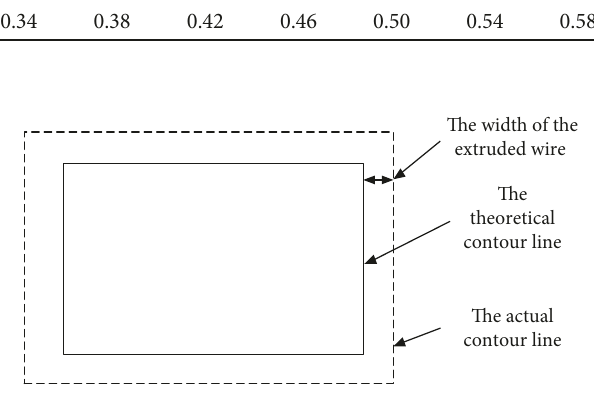
Figure 11: The error caused by the width of the extrusion wire.